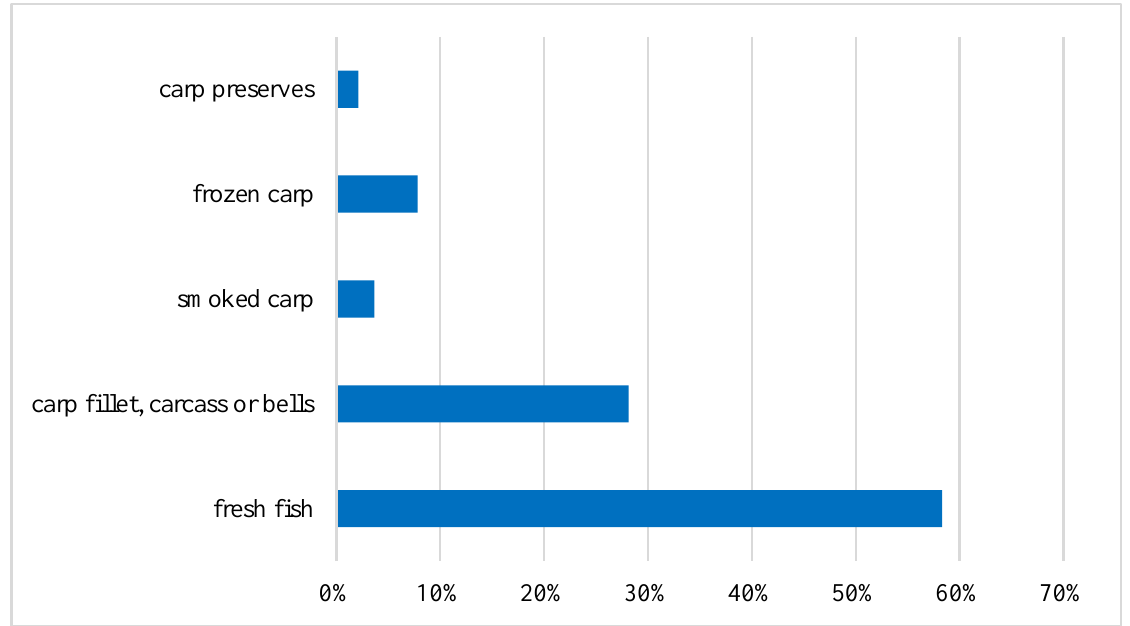
Figure 10. The preferences for the form of the purchased carp. Source: own elaboration based on data of [43].